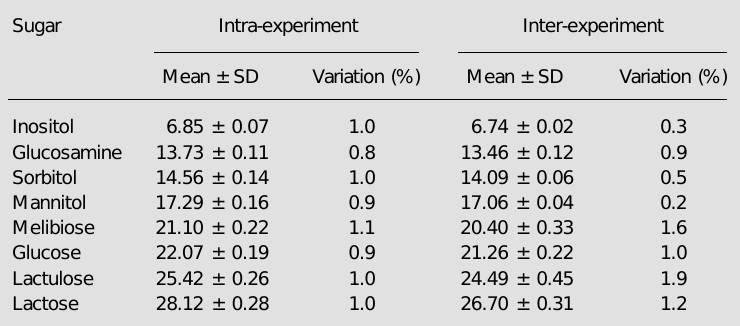
Table 2 - Intra- and inter-experiment variation of retention times of standard sugars measured by HPLC and pulsed amperometric detection. Data are reported as means ± SD of recovered picomoles of each